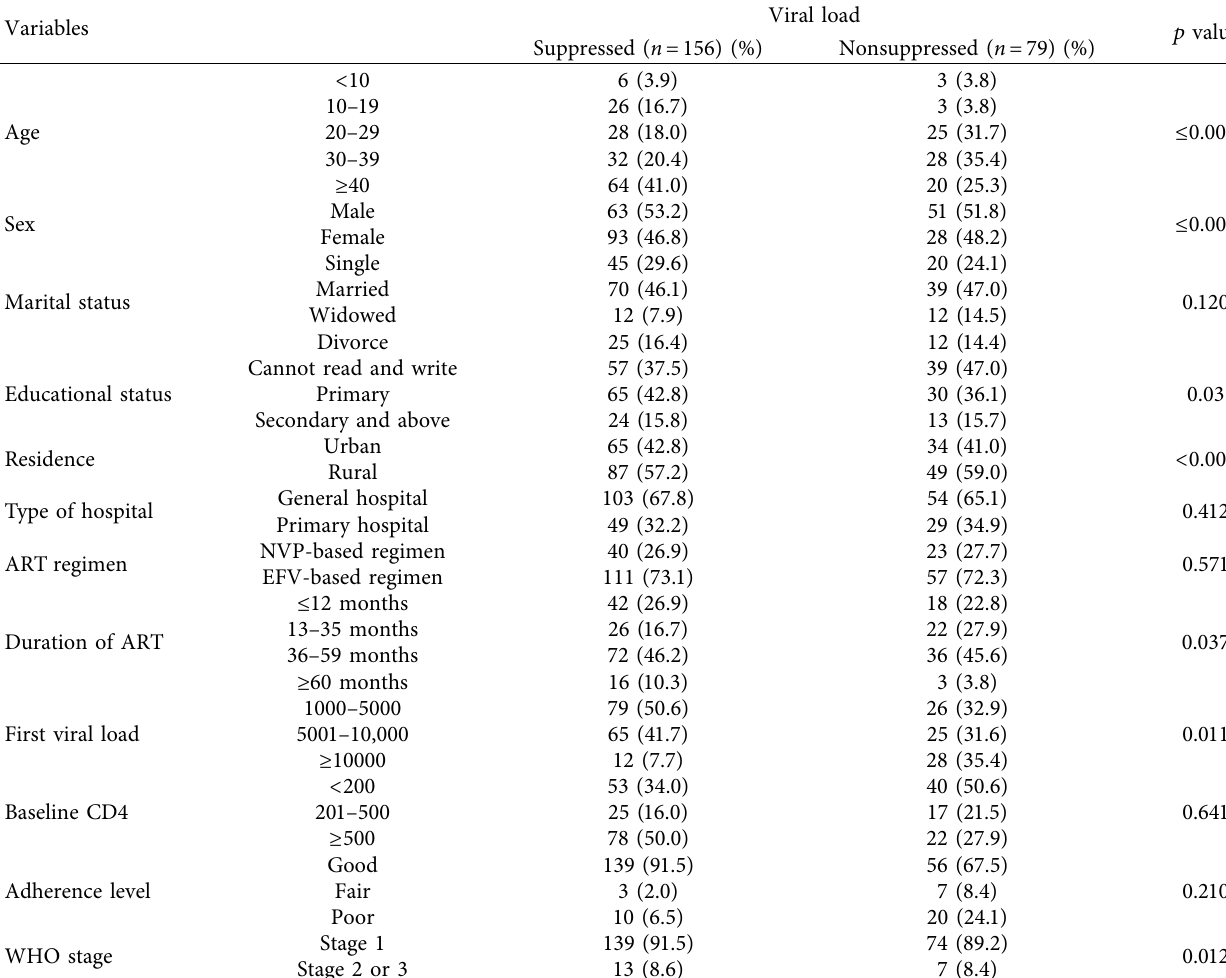
Table 2: Results showing relationship between baseline characteristics and viral load re-suppression among study participants.